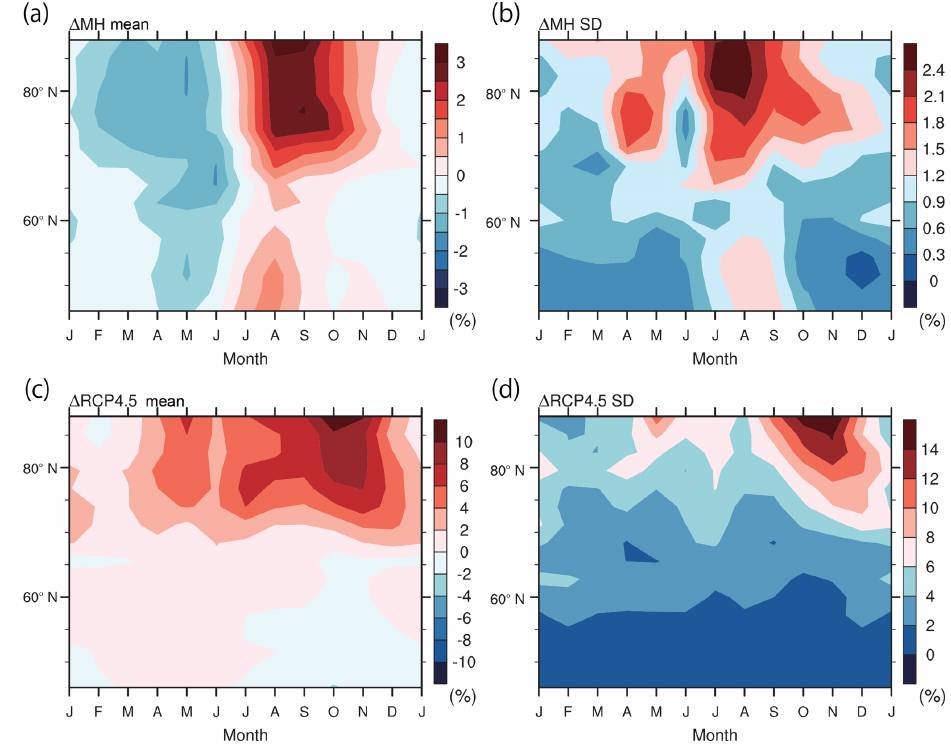
Figure 6. Seasonal progress of the total cloud fraction change (%) over the ocean (north of 60 ◦ N): (a) (cid:49) MH ensemble mean; (b) (cid:49) MH ensemble standard deviation; (c) (cid:49) RCP4.5 ensemble mean; and (d) (cid:49) RCP4.5 ensemble standard deviation. All 10 models listed in Table 2 are